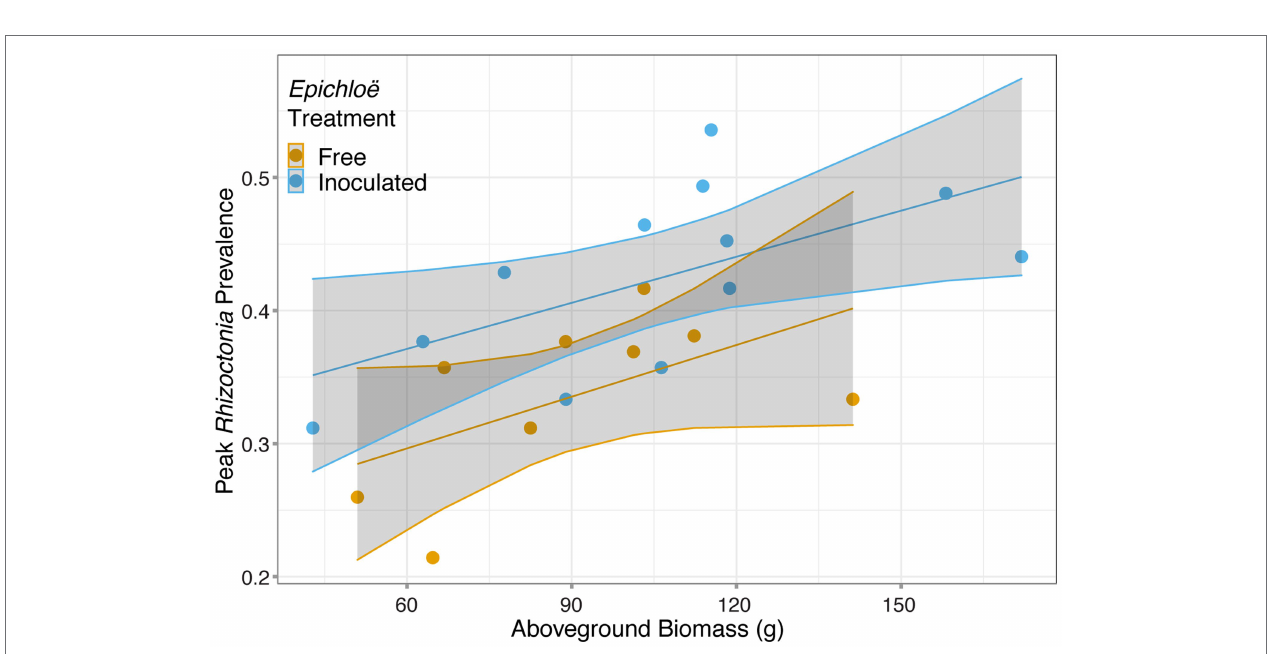
FIGURE 5 | Peak Rhizoctonia prevalence was correlated with dry aboveground biomass. Each population (represented with a point) was either inoculated with Epichloë (blue) or free of Epichloë (orange). Biomass predicted peak parasite prevalence ( p = 0.006), and independent of this effect, Epichloë inoculation increased peak prevalence by 0.07 ( p =